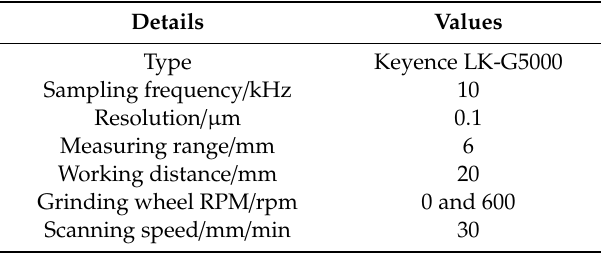
Table 1. Working parameters of the laser scan micrometer.